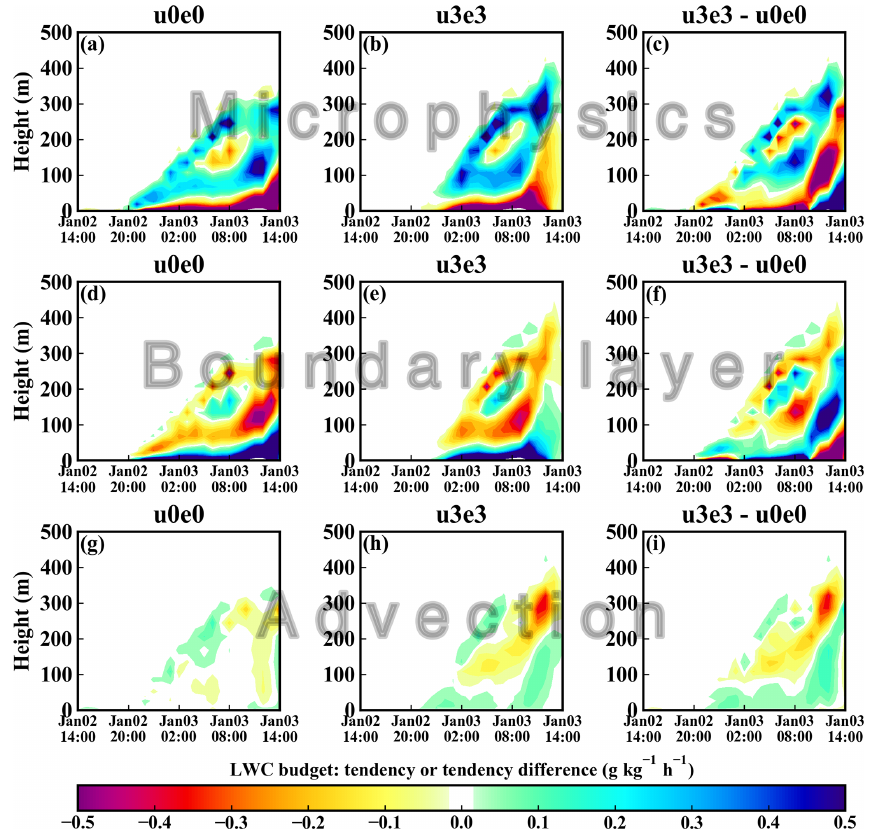
Figure 10. The combined effect of urbanization and aerosols (u3e3 minus u0e0) on various items of the LWC budget. The three rows are the tendencies (gkg − 1 h − 1 ) of the microphysical, boundary layer and advection